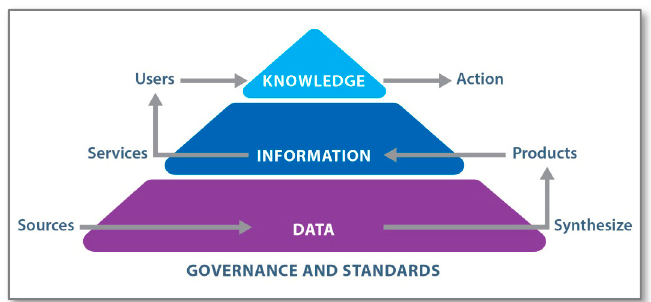
Figure 5. The data information knowledge triangle. Reproduced with the permission of the International Hydrographic Organization (IHO) Secretariat (Permission No 05/2020) acting for the International Hydrographic Organization (IHO), which does not accept responsibility for the correctness of the material as reproduced: in case of doubt, the IHO’s authentic text shall prevail. The incorporation of material sourced from IHO shall not be construed as constituting an endorsement by IHO of this product. Permission No 05/2020 Material from IHO publication C-17 Figure 3 – ”The Data Information Knowledge triangle” reference [14].